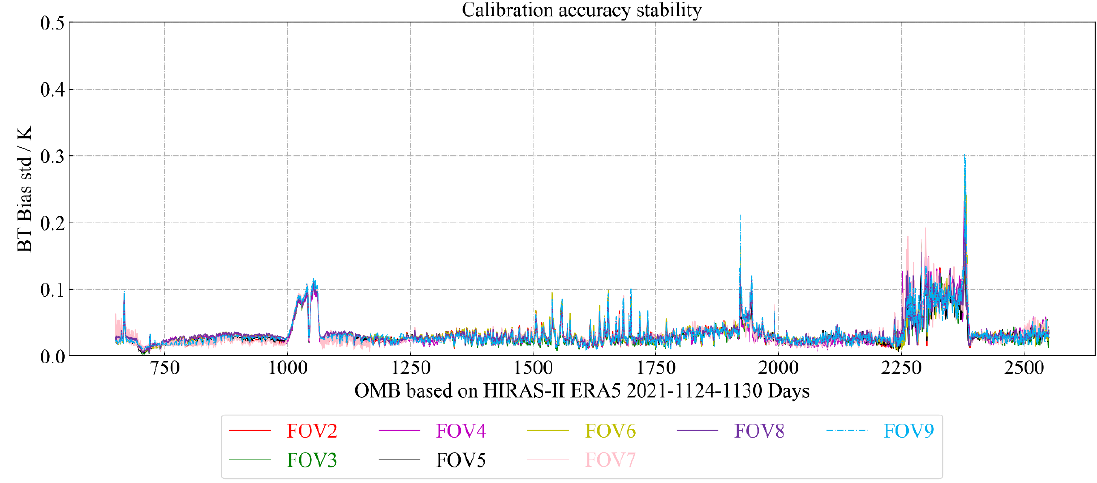
Figure 26. Calibration accuracy and stability of FY-3E/HIRAS-II.